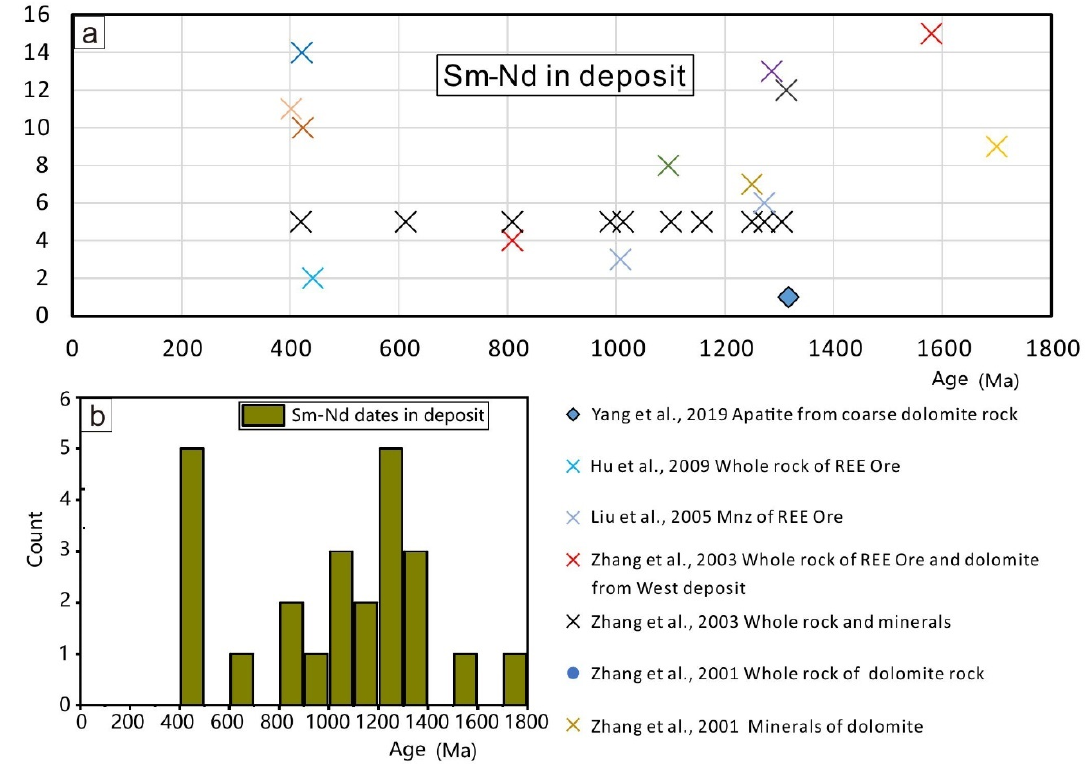
Figure 19. Age distribution characteristics of Sm–Nd in the ore deposit. ( a ) Single age distribution characteristics corresponding to different studies. ( b ) Stack histograms of all ages [1,17,34,50,51,59,60].